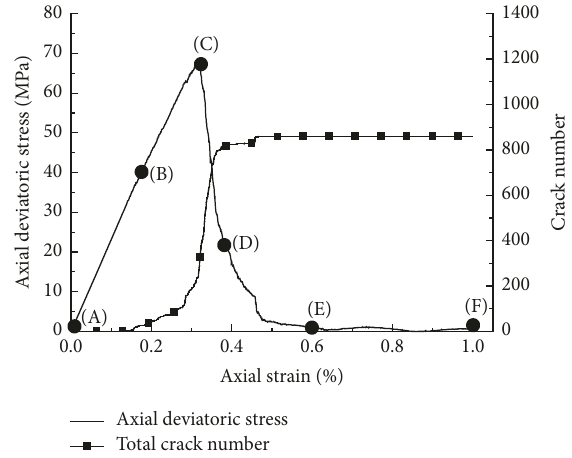
Figure 11: Evolution curves of axial deviatoric stress and crack number versus axial